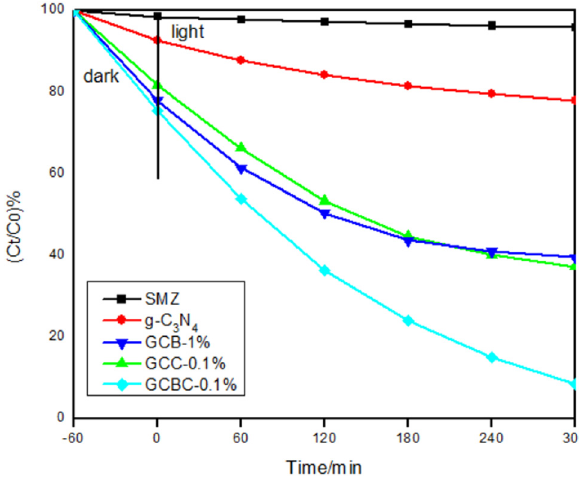
Figure 3: Photocatalytic degradation curve of